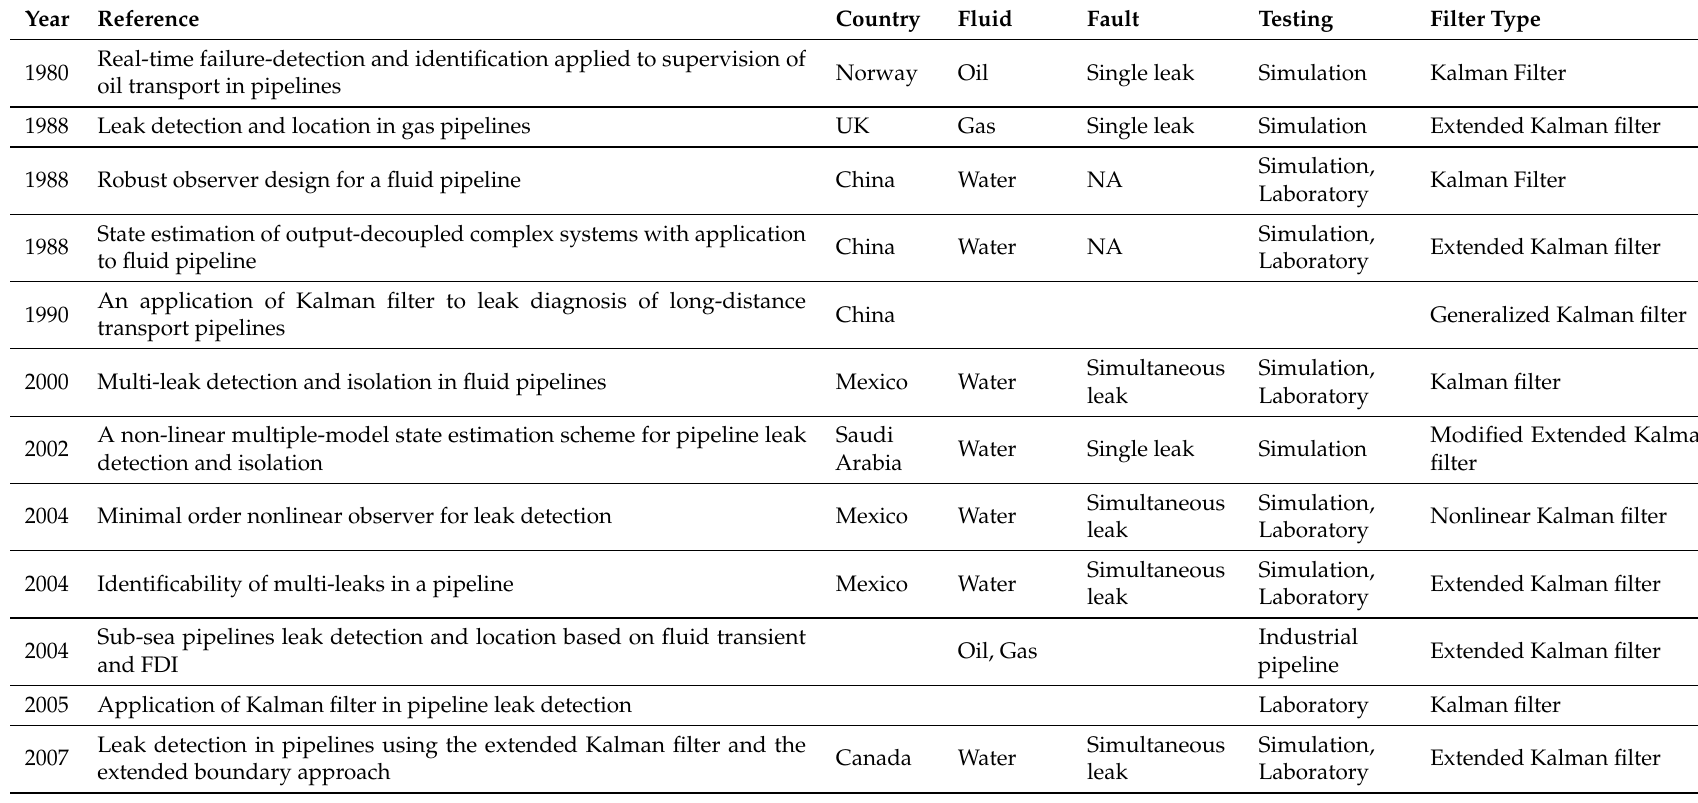
Table 2. Taxonomy of CPM